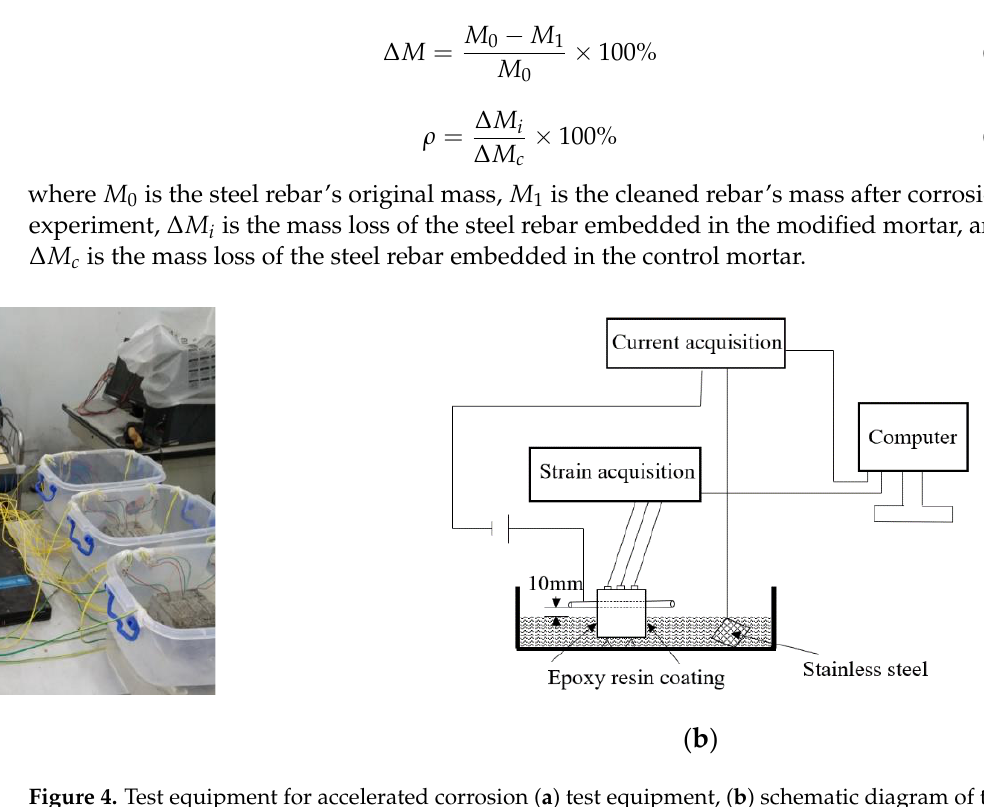
Figure 4. Test equipment for accelerated corrosion ( a ) test equipment, ( b ) schematic diagram of the test